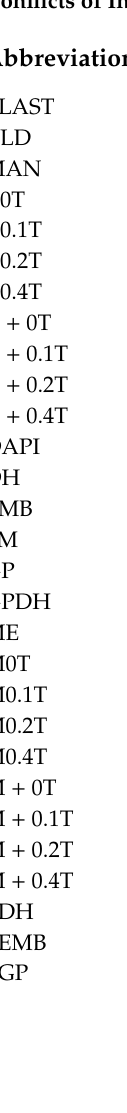
Figure S1: Scheme of the di ff erent strategies used to induce microspore embryogenesis in wheat anther culture by the application of trichostatin A (TSA) in combination with or without di ff erent stress